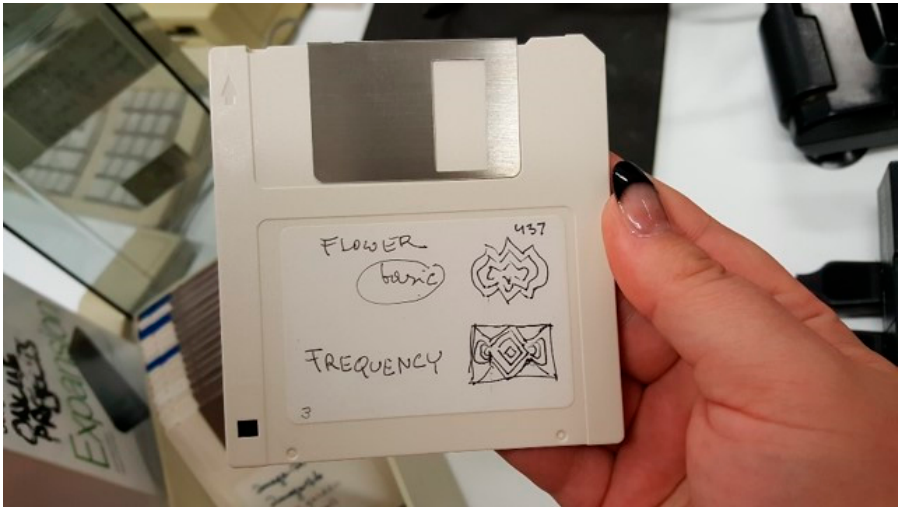
Figure 30. One of Ostoja’s floppy disks, showing his descriptive use of line drawings to label disks, and his reference to the Mandelbrot-derived images using everyday referents which they resembled in some way (“flower”, “frequency”). SLSA disks taken in Flinders Computer Archaeology Lab. Image courtesy Melanie Swalwell. Published with permission of SLSA. Arts 2019 , 8 , x FOR PEER REVIEW